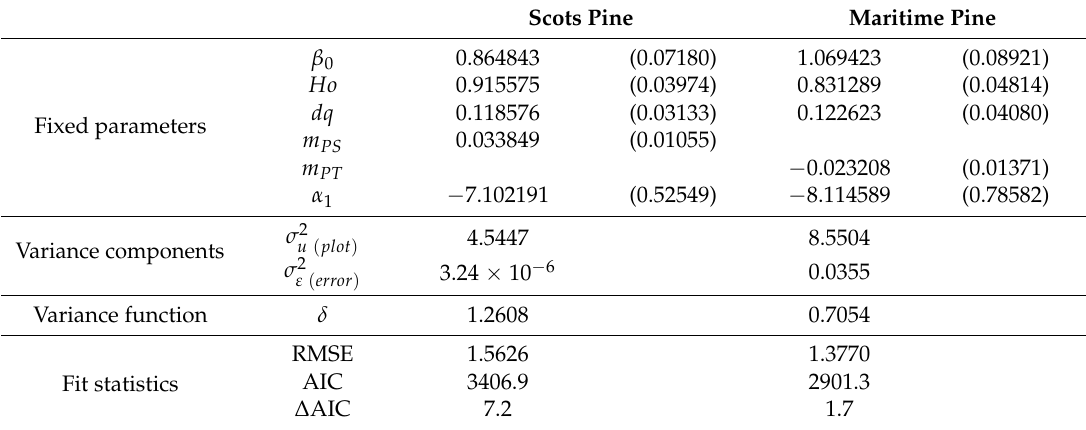
Table 2. Parameter estimates, variance components, and goodness-of-fit statistics for the final generalized h-d model selected for each species. All of the parameters were significant with p < 0.05, standard errors in brackets. ∆ AIC is the reduction in AIC achieved by including species mixing proportion in Equation (4). Scots Pine Maritime Pine β Fixed parameters